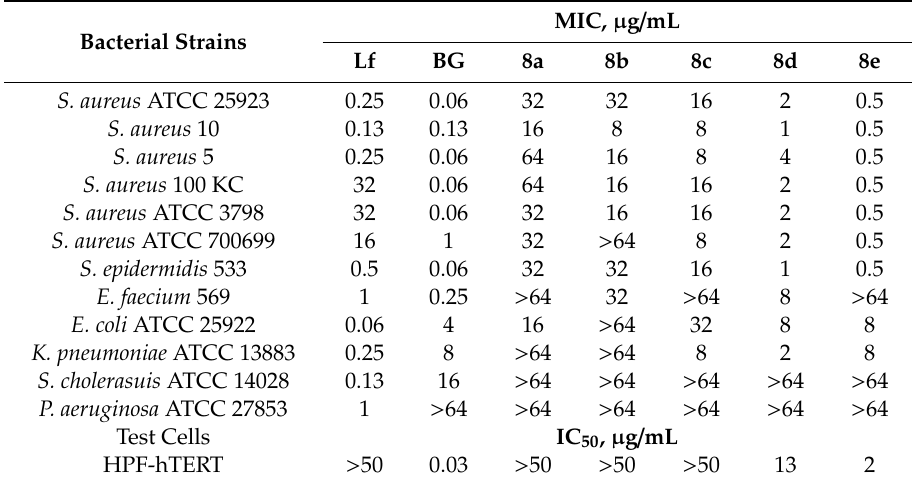
Table 1. Antibacterial and cytotoxic activity of 8a–e . Bacterial